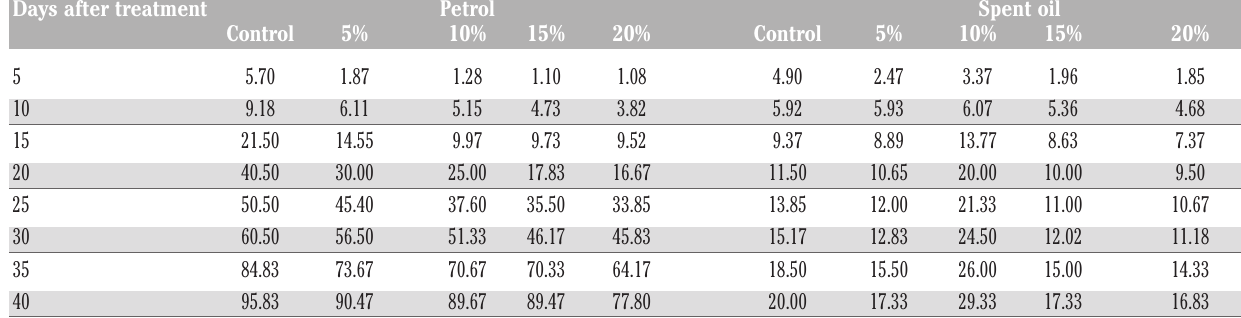
Table 4. Effect of different concentrations of petrol and spent oil on the leaf area of Guinea corn. Days after